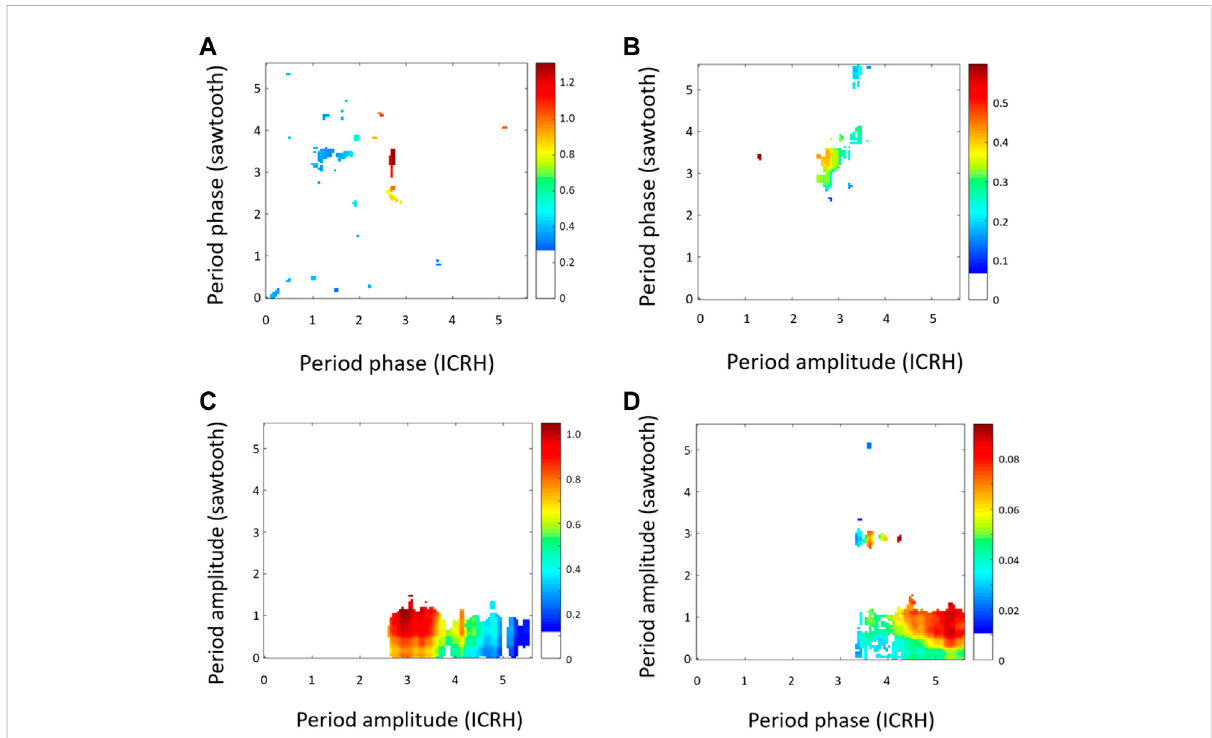
FIGURE 11 CMI plots patterns showing causal interactions between ICRH modulation and sawteeth time series for JET pulse #90005, for the time interval 48.5 – 55.5s: phase-phase (A) , amplitude-phase (B) , amplitude-amplitude (C) and phase-amplitude (D) . Amplitude-amplitude and amplitude-phase causal interactions are dominant but phase-amplitude coupling is also detectable. The distinctive features on the maps are relatively similar for L- modeandH-modephasesofthepulses.ThecolourcoderepresentsthelevelofcouplingderivedwiththeconditionalmutualinformationCMI. Periods are measured in seconds. The fi gures display the positive signi fi cance-level deviations from the 99th percentile of the average CMI calculated using 50 Fourier transform